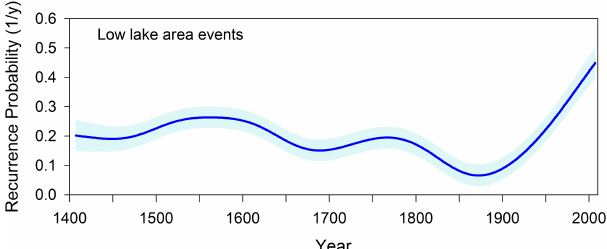
Figure 4. Changing probability of extreme low values ( < 20th per- centile; blue line) of the Vilama-Coruto lake area reconstruction from 1407–2007. A kernel smoothing method was used with a bandwidth of 50years. The shaded represent 95% confidence in- terval based on 1000 bootstrap simulations.